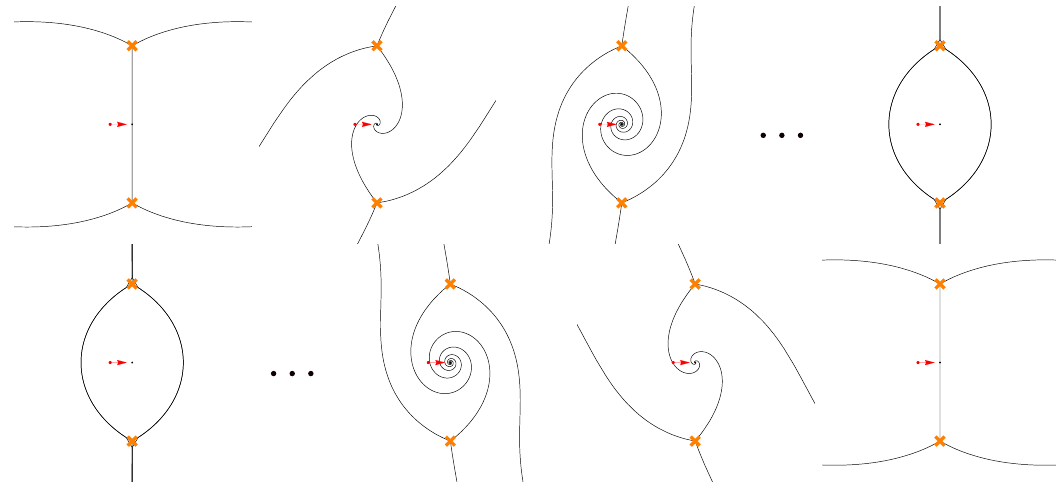
Figure 6. Sequence of spectral networks near a regular puncture. The red dot marks z 2 C , the parameter of the surface defect, while the red arrow denotes a choice of \resolution" of the surface defect into an in(cid:12)nitesimal interface. The top line illustrates phases from sector I as described in (3.22), for phases ranging from # c (cid:0) (cid:25)= 2 (top-left) to # c (top-right). In the second frame, an S -wall passes through z , the charge of the soliton carried by the wall is a (cid:22) {i , as de(cid:12)ned in (3.19). In the third frame, an S -wall passes through z , it carries solitons a (cid:22) {i + (cid:13) ( i ) , as de(cid:12)ned in (3.21). R The bottom line illustrates phases from sector II as described in (3.25), for phases ranging from # c (bottom-left) to # c + (cid:25)= 2 (bottom-right). The S -wall passing through z in the second-to-last frame carries a soliton with charge (cid:0) a (cid:22) {i + (cid:13) ( i ) , whereas the one in the third-to-last frame L